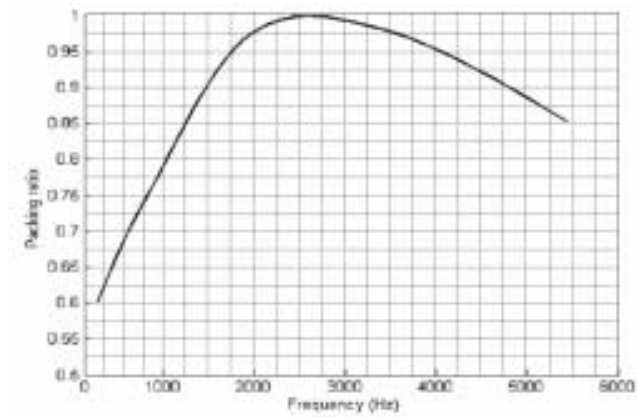
Fig. 28. The relationship between packing ratio and